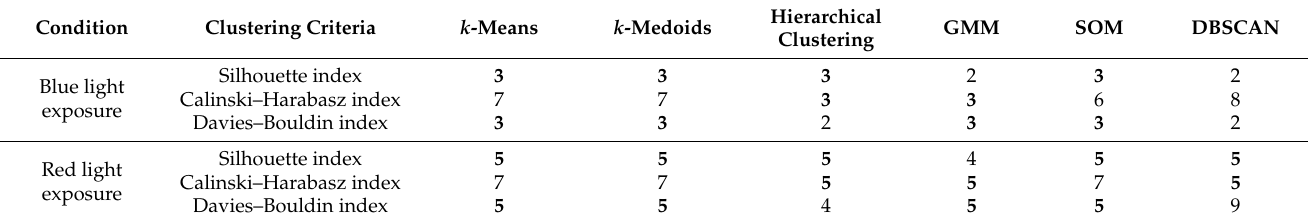
Table 2. The optimal number of clusters for the best set of parameters ([HHb]-PFC, [O 2 Hb]-VC, P ET CO 2 , SC, and SpO 2 ) using six different clustering methods and evaluated with three clustering